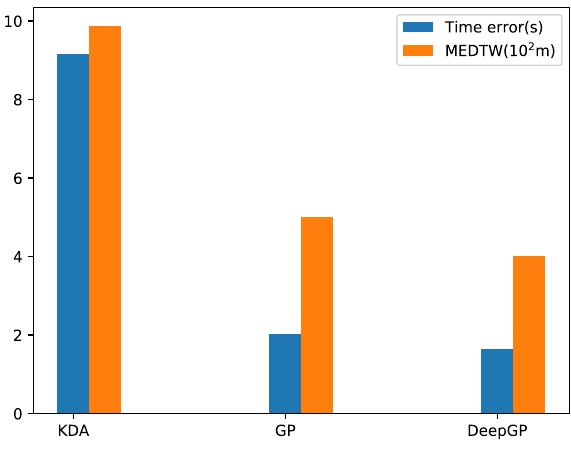
Figure 14. Experimental results for a decelerating flight.